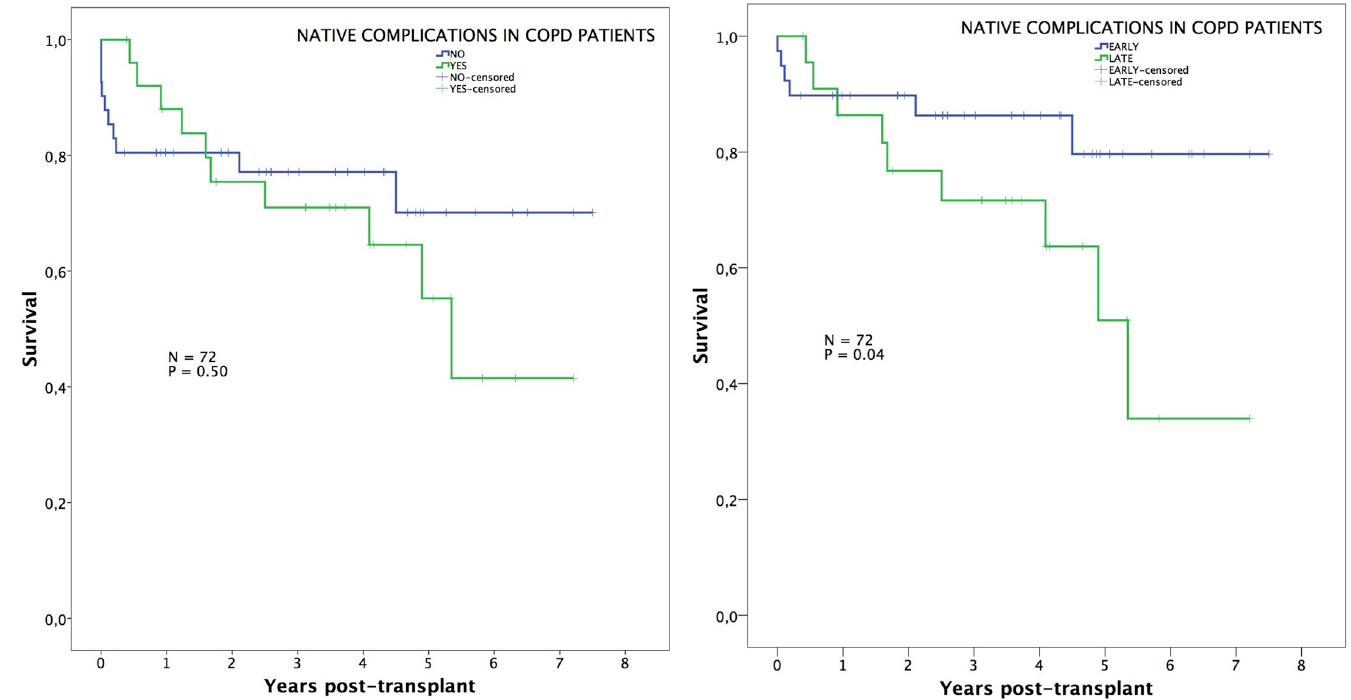
Fig 3. Survival in COPD patients. Post-transplant survival of COPD patients comparing those with or without native lung complications (left), and those with early or late native lung complications (right).